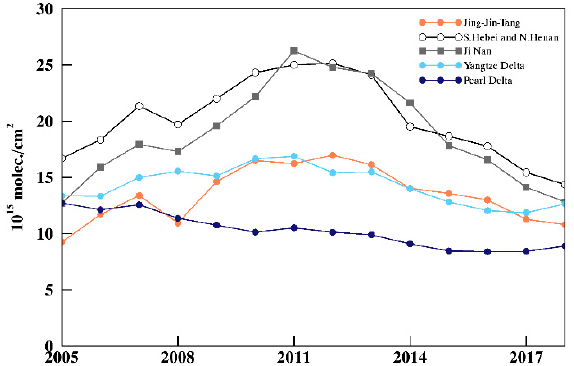
Figure 4. Annual variations in tropospheric NO 2 VCD in the five hotspots we selected during 2005–2018. (unit: 10 15 molec cm − 2 ).